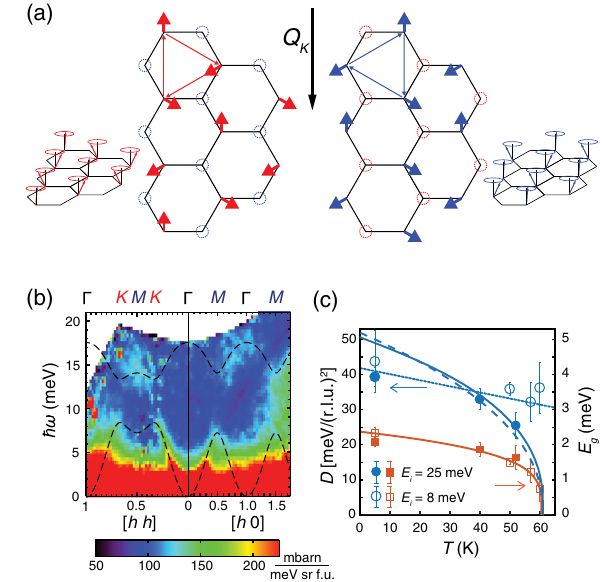
FIG. 4. (a) The spin displacements of the two sublattice spins at the right-handed chiral wave at K points. The long arrow at the center denotes the direction of spin-wave propagation. The thin triangular arrows mark the direction of rotation for the right- handed chiral within a hexagon. (b) Spin-wave excitations at T ¼ 52 K. The dashed lines are the calculations using the best- fitting parameters from the data at T ¼ 5 K but with D set to z be 0. (c) Temperature dependencies of the stiffness of the acoustic mode [ D ð T Þ , circle] and the anisotropy gap ( E , square) obtained g by fitting the data integrated over − 5 ≤ l ≤ 5 . For this reason, the absolute values of E are overestimated by the factor of g approximately 2 . The open and closed symbols are the results ¼ 8 and 25 meV, respectively. The blue solid obtained using E FIG. 3. (a) – (d) The neutron scattering intensities experimen- i and dashed lines are expected D ð T Þ from 3D Heisenberg and tally observed at 5 K are directly compared with the calculated Ising models, respectively. intensities and dispersions discussed in the text. The exper- imental data on the right panels were integrated over − 5 ≤ l ≤ 5 . The calculations on the left panels used the best- ¼ 0 as discussed in the text, and fitting parameters with J c convoluted by the effective energy resolution of δ ð ℏ ω Þ ¼ 1 . 8 meV considering the band with along l . The displayed cuts are described in (e) within the ð h; k Þ plane. (f) 3D view of the 2D spin-wave excitations of CrI 3